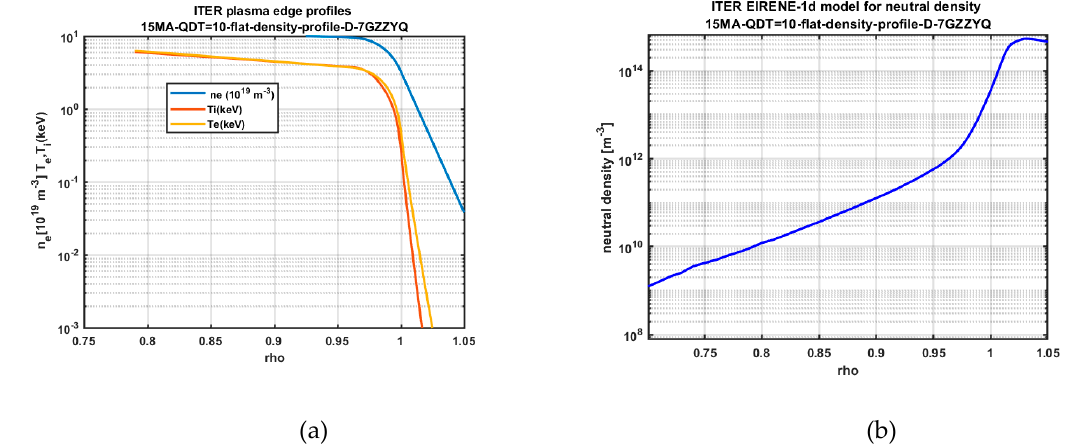
Figure 5. ( a ) Exponential extrapolation of plasma profiles beyond separatrix ( ρ = 1) to wall location assumed at ( ρ = 1.05) ITER 15 MA-QDT-10-flat density scenario; ( b ) EIRENE neutral density modeling for atomic density (nH)). ITER 15 MA-QDT-10-flat density